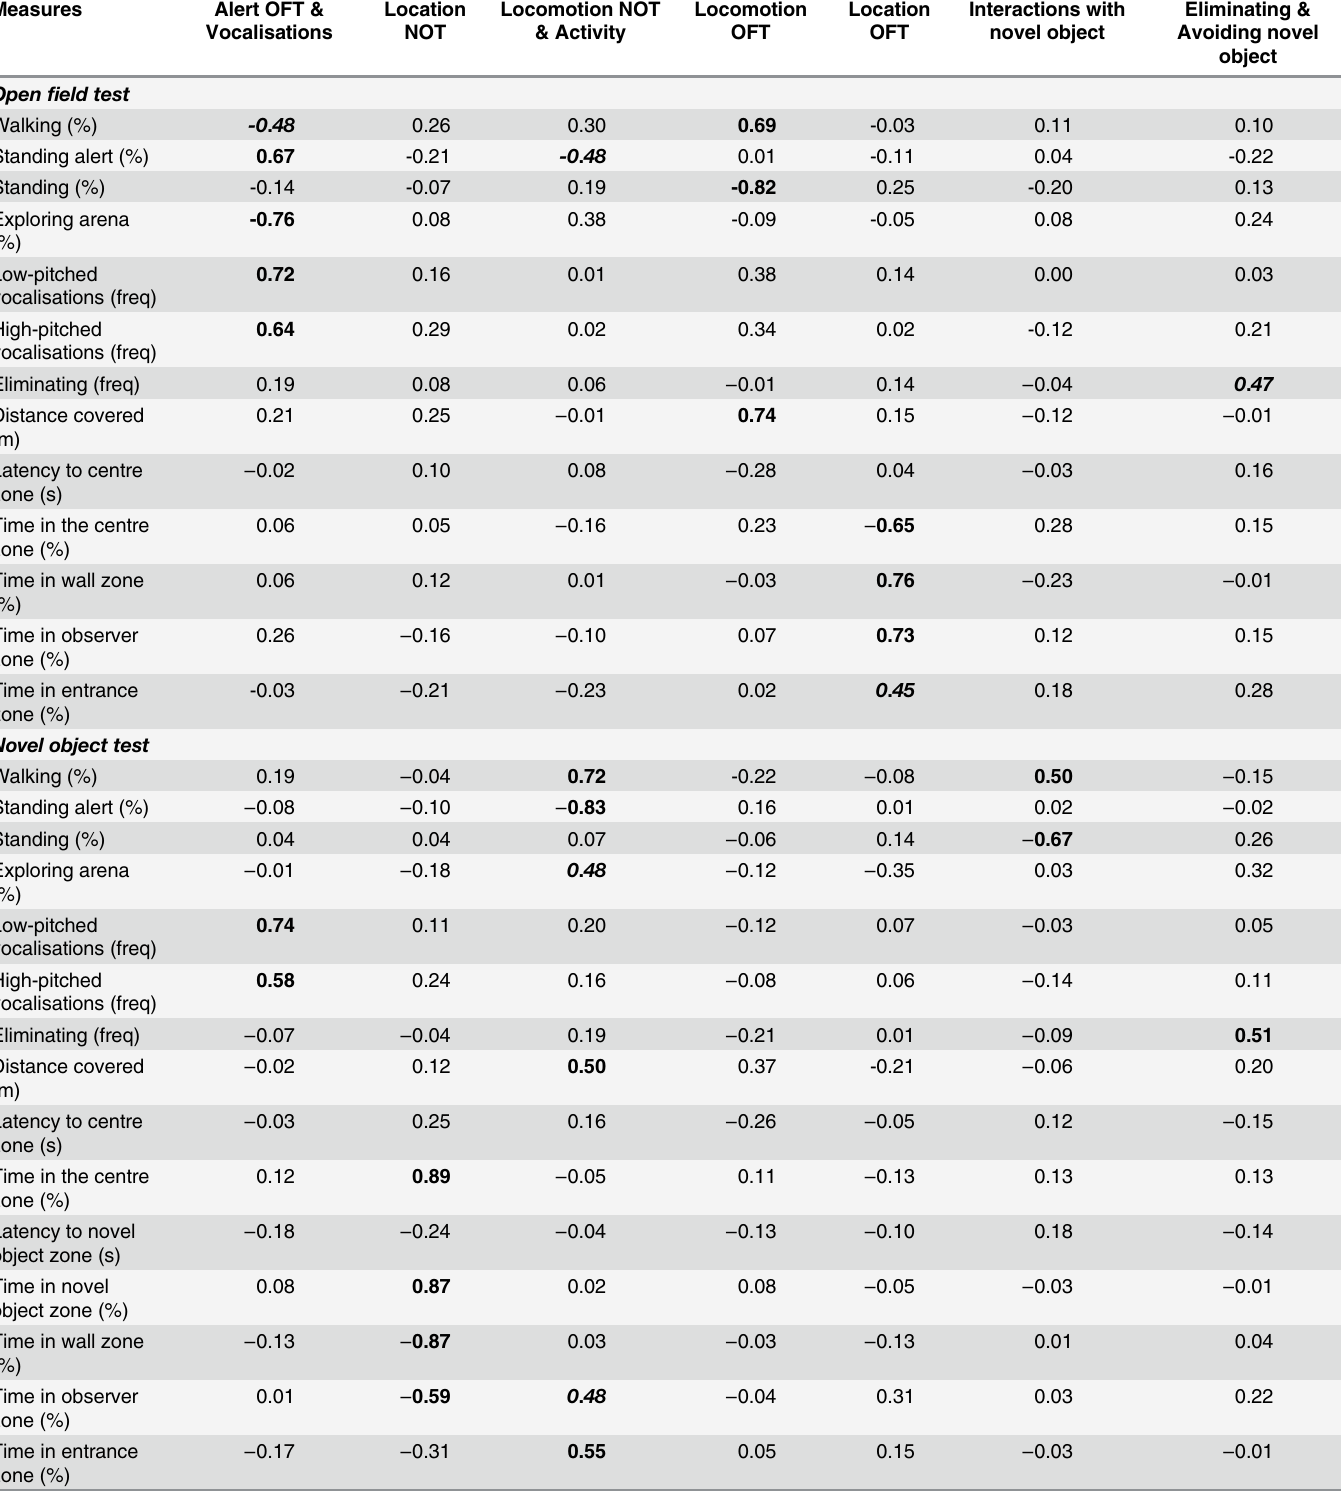
Table 5. Loadings on the factors extracted by principal component analysis, after orthogonal rotation, of variables recorded on individual